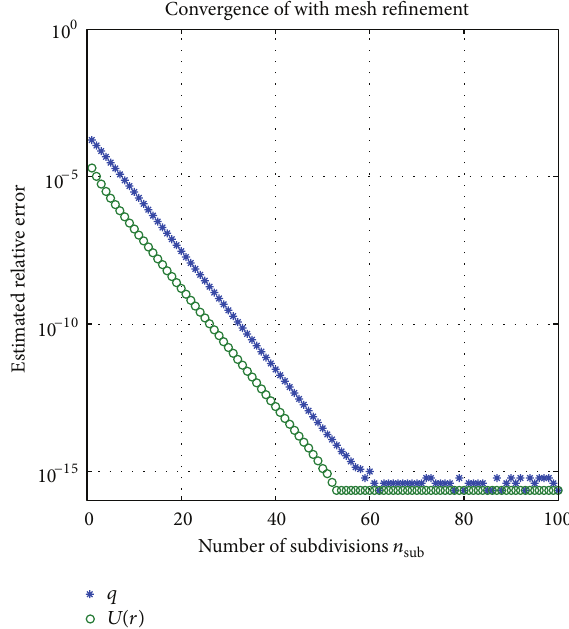
Figure 12: Similar as Figure 7(a) but with the program demo3c.m . The potential 𝑈(𝑟) at 𝑟 = (0.4, 0.1) is evaluated via (41), and npan = 14 is